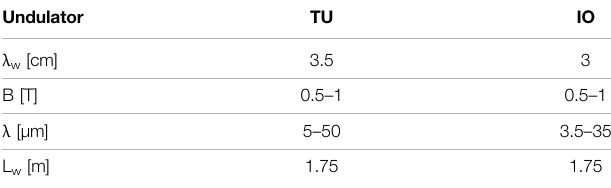
TABLE 4 | TerRa@BriXSinO parameters of the undulators with permanent magnets, variable gaps, and linear polarization. First module is the